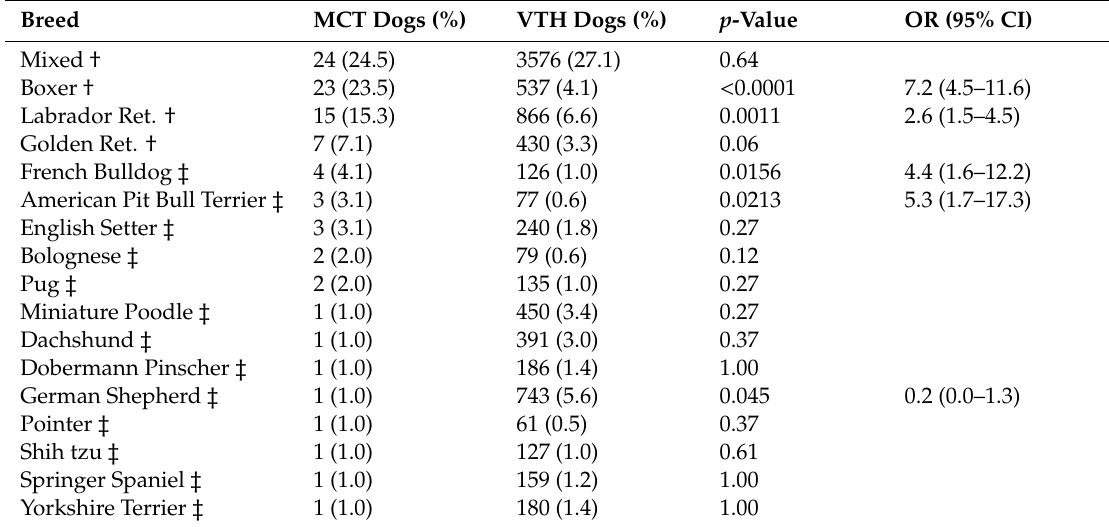
Table 1. Odds Ratios (OR) and 95% confidence interval for MCT frequency by